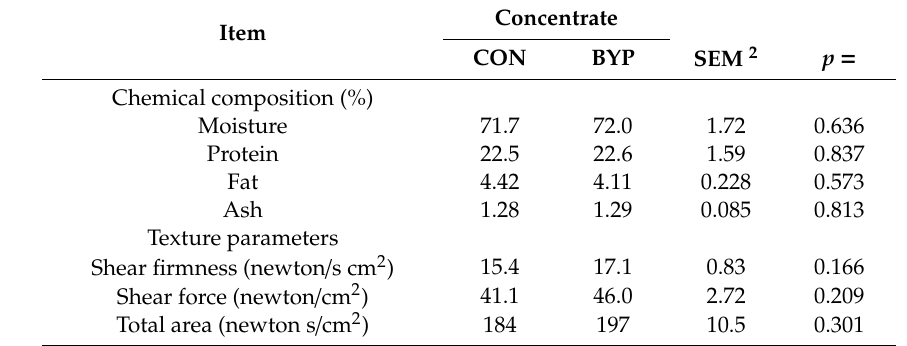
a,b,c Within each variable, mean values in the same row with di ff erent superscripts di ff er ( p < 0.05). 1 The BYP concentrate contained 18% corn DDGS, 18% dried citrus pulp, and 8% exhausted olive cake (as-fed basis). 2 EEM D and EEM T: standard error of the mean for diet and time e ff ects, respectively. Table 4. Chemical composition and texture parameters of the longissimus dorsi muscle of light lambs fed either a high-cereal concentrate (CON) or a concentrate including by-products (BYP) 1